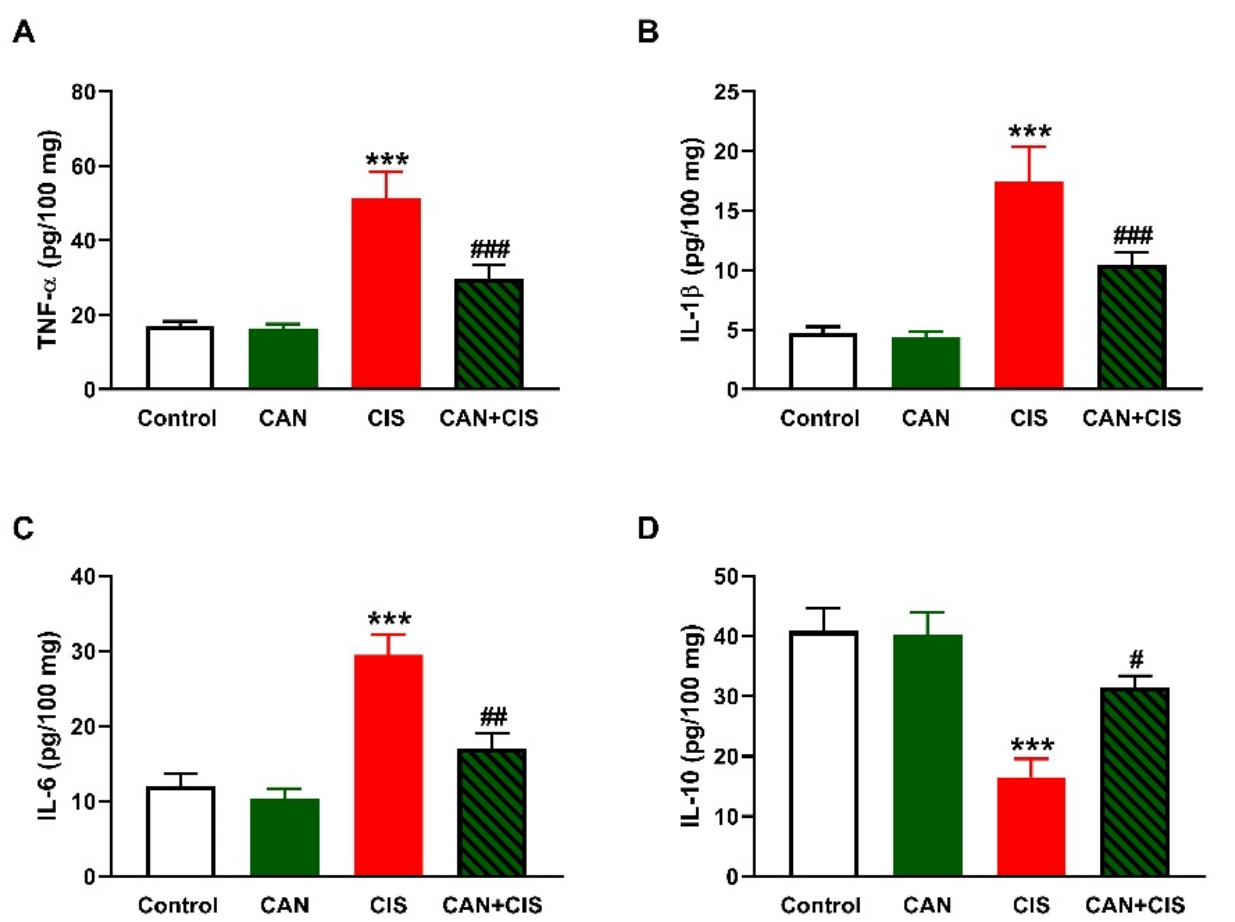
Figure 4. CAN decreased TNF α ( A ), IL-1 β ( B ), and IL-6 ( C ), and increased IL-10 ( D ) in the lungs of CIS-administered rats. Data are Mean ± SEM, ( n = 8). *** p < 0.001 vs. Control, and # p < 0.05, ## p < 0.01 and ### p < 0.001 vs. CIS.